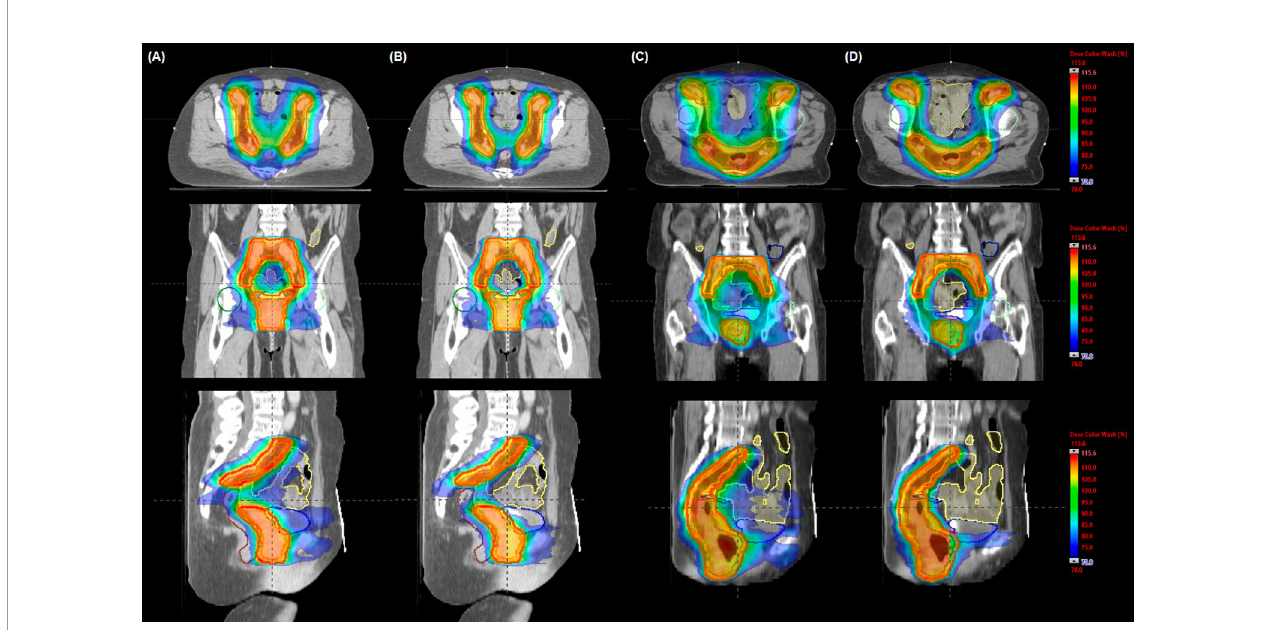
FIGURE 2 | Comparison of representative dose distributions in volumetric modulated arc therapy (VMAT) plans for a cervix (A, B) and an anal (C, D) cancer case. The dose was optimized using (A, C) a fully opened fi eld size (VMAT-FF) to cover the planning target volume and (B, D) a half-beam technique (VMAT-HF). Isodose and structures displayed as a color-wash overlay and delineated contours, respectively: red for planning target volume, yellow for small bowel, navy for colon, brown for anorectum, blue for bladder, green for right femur head, and cyan for left femur